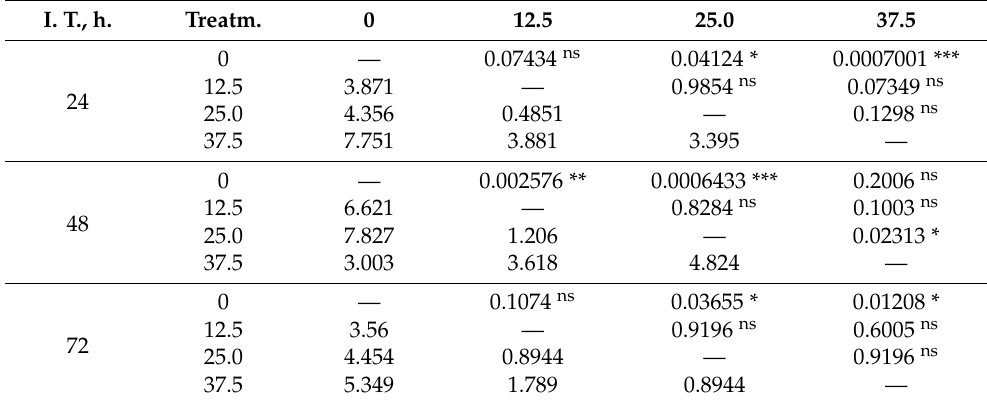
Table 4. Comparison of means of mean germination time (MGT) with 24, 48, and 72 h of immersion in Biozyme ® TS (gibberellins), according to Tukey HSD.